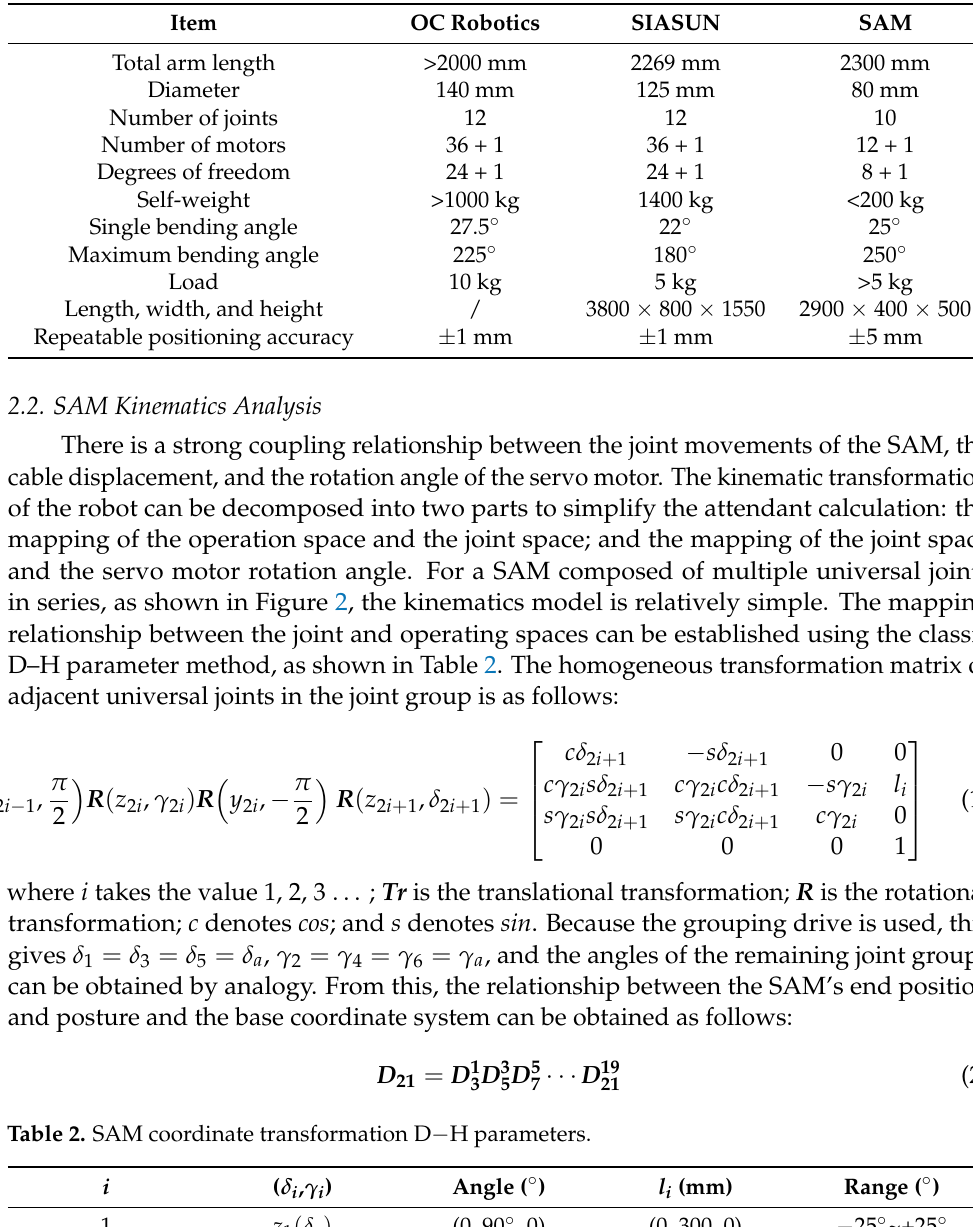
Table 1. Comparison of the parameters of rigid hyper-redundant robots and SAMs [11,34].